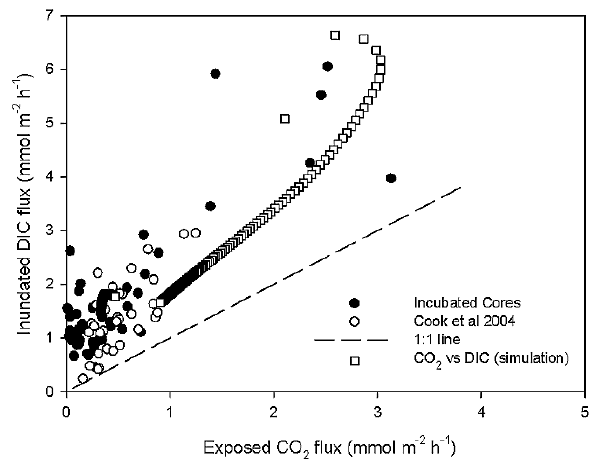
Fig. 3. Fluxes of dissolved inorganic carbon (DIC) versus exposed CO 2 fluxes for two experimental datasets and a model simulation. Incubated core experiments represent both the + and − OM treat-